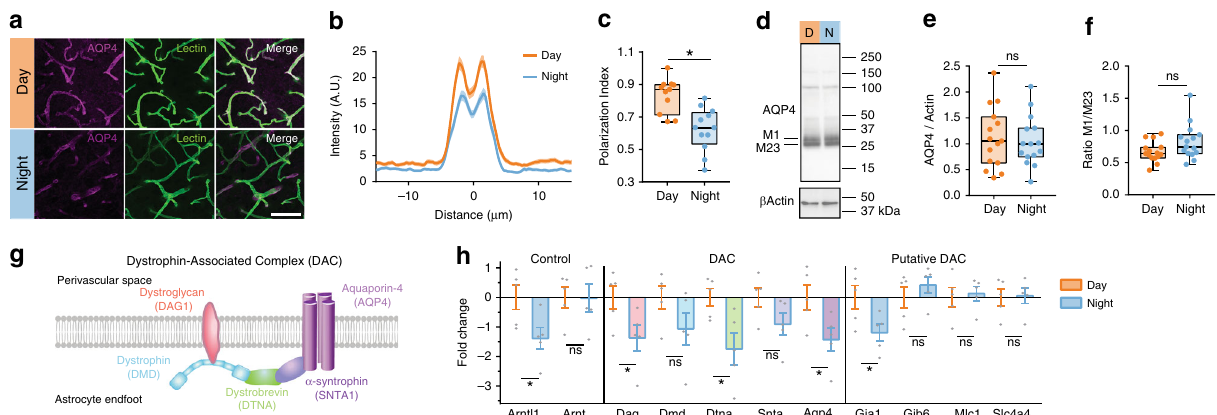
Fig. 3 Diurnal variation in AQP4 protein and localization. a Representative ×63 magni fi cation confocal images during the day (ZT6) and night (ZT18). Purple is AQP4, green is vascular staining, white is overlap between both AQP4 and vascular staining. White scale bar: 50 µ m. b Average intensity of AQP4 staining centered on vasculature in the cortex during the day (orange, for b , c : n = 11 mice, 99 vessels) and night (blue, for b , c : n = 12 mice, 108 vessels), with mean ± SEM indicated by the thick line (mean) with shading (SEM). c Average polarization index boxplot. Polarization index equals peak vascular end foot fl uorescence minus 10 µ m baseline. All values were normalized to the highest signal for ease of visualization. Two-sided t test, p = 0.0004. d Representative western blot for AQP4 and β Actin loading control during the day (orange) and night (blue). Molecular weights are indicated to the right. M1 and M23 splice variants of AQP4 monomers are indicated on the left. e Bloxplot of mean AQP4 densitometry normalized to the loading control. For e , f : n = 15 mice per group. f Bloxplot of the ratio of M1/M23 densitometry, both normalized to loading control. g Schematic of key components of the dystrophin-associated complex. h Bar plot of day (ZT6) and night (ZT18) mRNA expression of target genes assessed by RT-qPCR means with error bars indicating SEM. Gray dots are individual mice. n = 5 mice per group. Two-sided Welch ’ s t tests: Arntl1 , p = 0.037; Dag , p = 0.0483; Dtna , p = 0.0283; Aqp4 , p = 0.038; Gja1 , p = 0.045. DTNA, DMD, DAG1, AQP4, GJA1, GJB6, MLC1, and SLC4A4 are all upregulated in astrocytes at minimum two times more than any other cell type 30 . All boxplots: minima is minimum value, maxima is maximum value, center is median and quartiles shown by box and whiskers, with individual animals shown as colored dots. Asterisk indicates p < 0.05; ns: not signi fi cant. Source data are provided as a Source Data fi